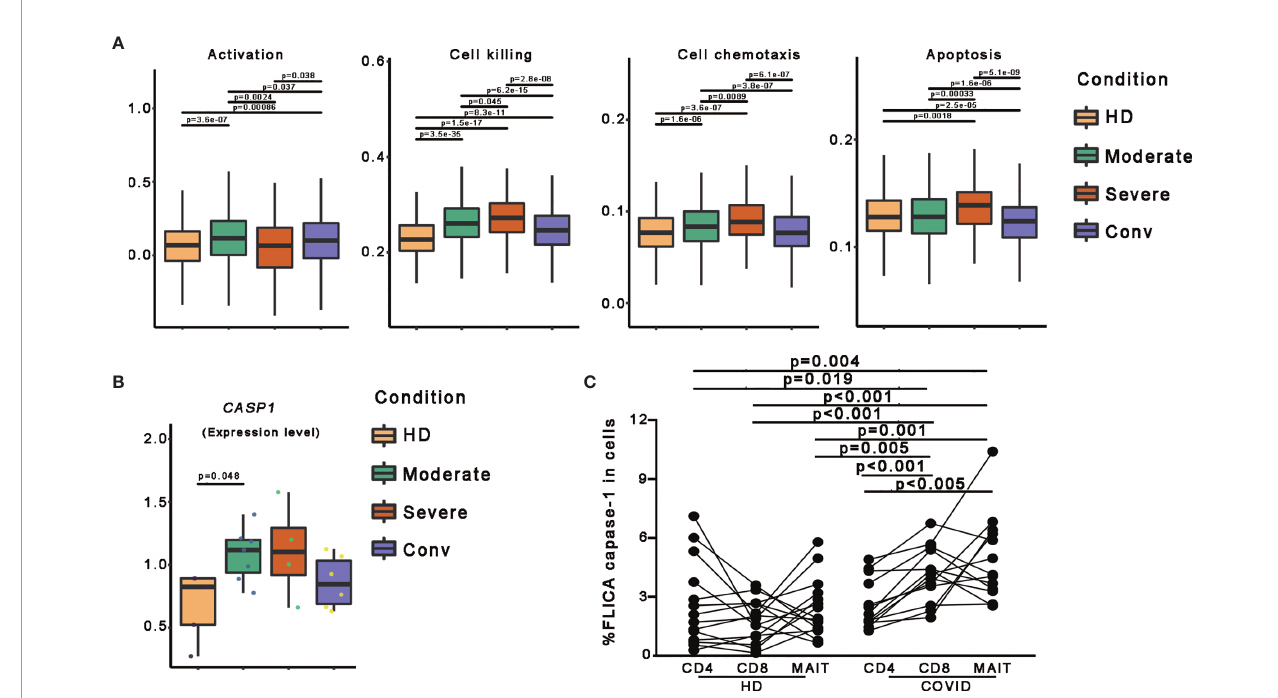
FIGURE 3 | Pyroptotic MAIT cells increased in patients with COVID-19. (A) Box plots of the expression levels of genes associated with four GO biological process in MAIT cells derived from the HD (n = 5), moderate (n = 7), severe (n = 4), and conv (n = 6) samples. Conditions are displayed in different colors. Horizontal lines represent median values, with whiskers extending to the farthest data point within a maximum of 1.5×the interquartile range. (B) The expression level of the CASP1 gene in participants from four conditions. A dot represents a single sample. Samples and their corresponding conditions are displayed in different colors. (C) Comparisons of FLICA caspase-1 in peripheral CD4 + T, CD8 + T and MAIT cells from healthy donors and patients with COVID-19. Statistical analysis was performed using SPSS software version 22 (IBMCorp., Armonk, New York, USA). For comparison, the Mann – Whitney U test was used for comparisons between healthy donors and patients with COVID-19. A paired Student ’ s t-test was adopted for the analysis of CD4 + T, CD8 + T and MAIT cells in the same group. p values < 0.05 indicated a signi fi cant difference. HD, healthy